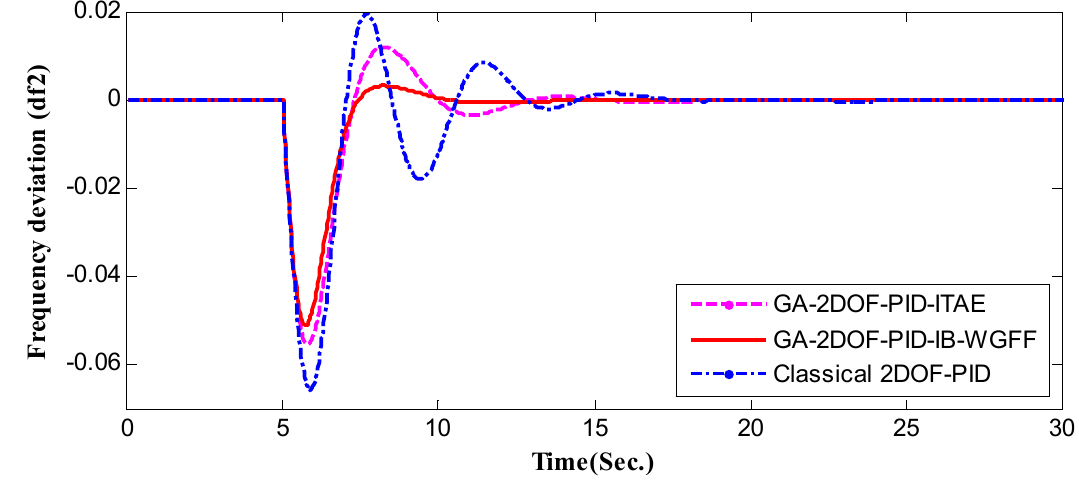
Figure 19. Δf (cid:2870) , using GA implementing ITAE, IB-WGFF and classical 2DOF-PID.